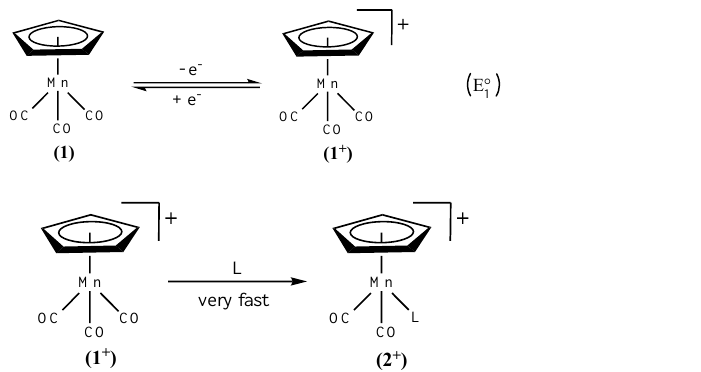
Table 1. Cyclic Voltammetric data obtained for oxidation of 5 mM 1 in ILs.